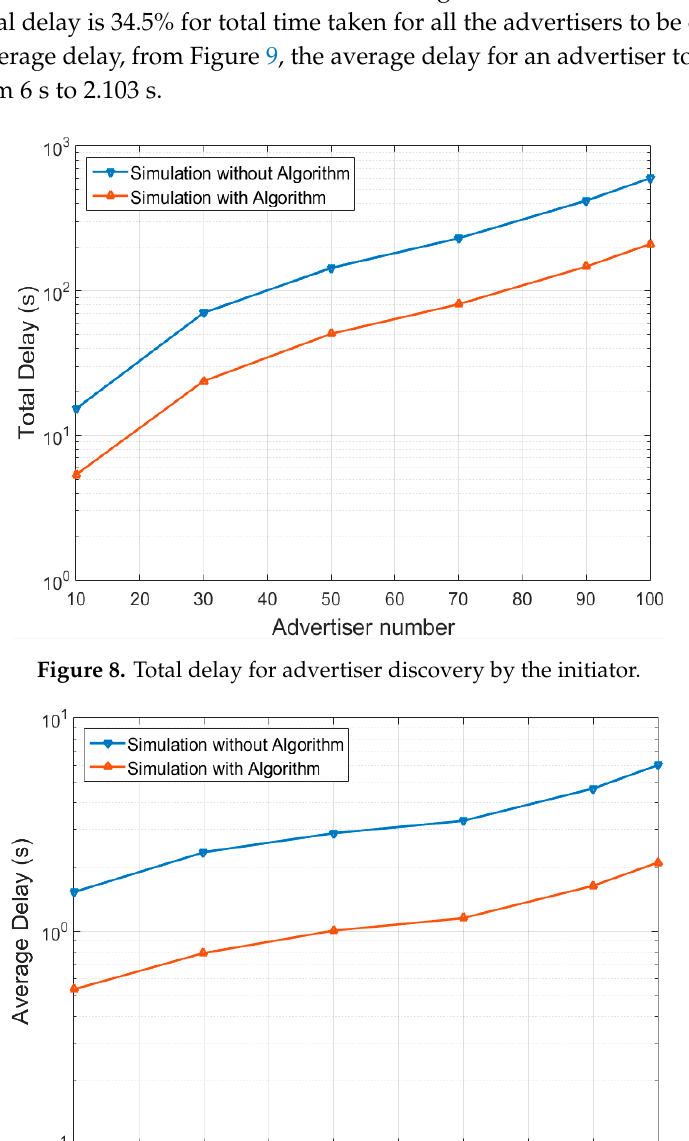
Figure 9. Average Delay for advertiser discovery by the initiator.